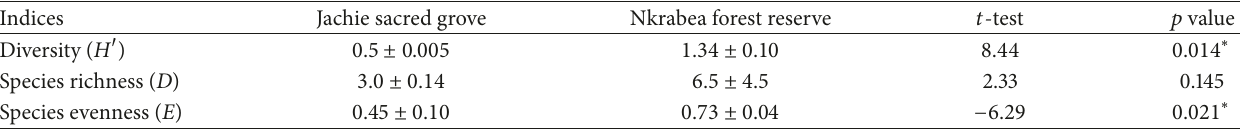
Table 3: Summary of arthropod diversity and evenness distribution, in Jachie sacred grove and Nkrabea forest reserve. Indices